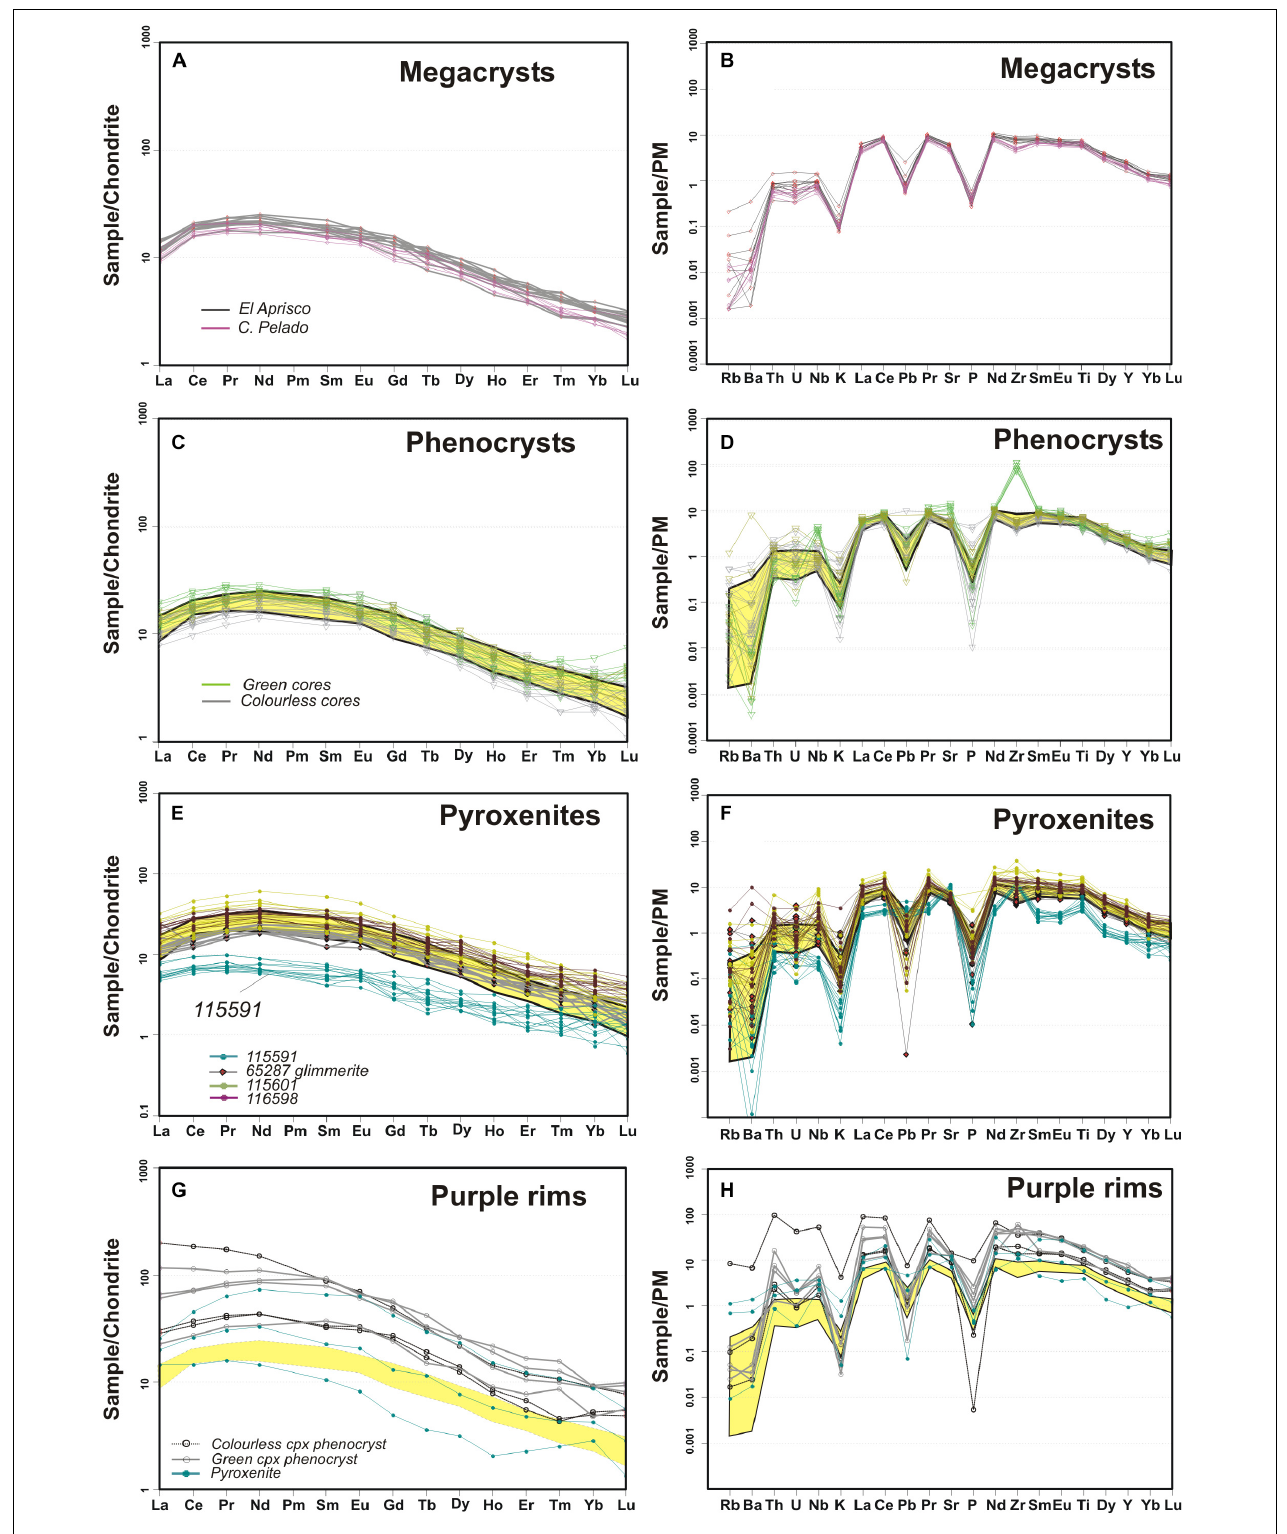
FIGURE 6 | REE and trace element composition of clinopyroxene: (A) and (B) megacrysts, (C) and (D) green and colorless phenocryst cores, (E) and (F) clinopyroxenite enclaves and (G) and (H) purple rims on colorless and green phenocryst cores and on clinopyroxene grains from pyroxenite enclaves. Chondrite-normalizing values are from Boynton (1985), whereas primitive mantle (PM) normalizing values are from Sun and McDonough (1989). The compositional field of clinopyroxene megacrysts (yellow field) is plotted in diagrams (C–H) .